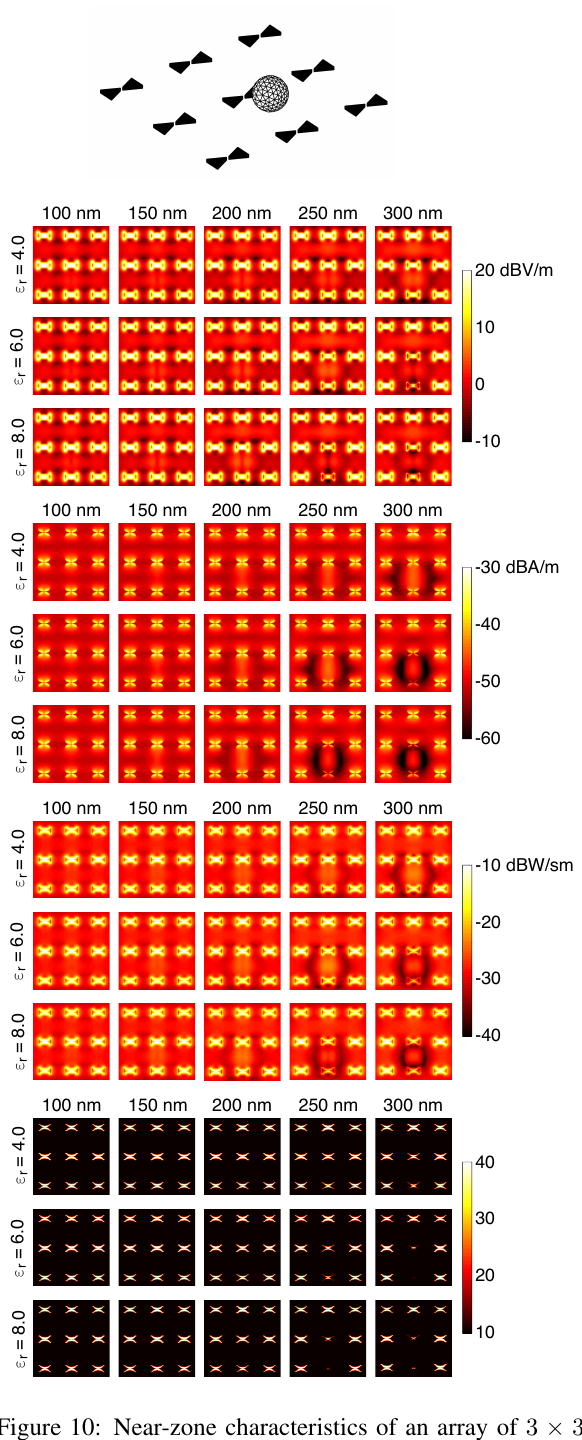
Figure 10: Near-zone characteristics of an array of 3 × 3 nanoantennas when dielectric particles with different sizes ( 25 – 300 nm diameter) and permittivity values of 4 . 0 , 6 . 0 , and 8 . 0 are located above the array. The distance between the particles and surfaces of nanoantennas is 20